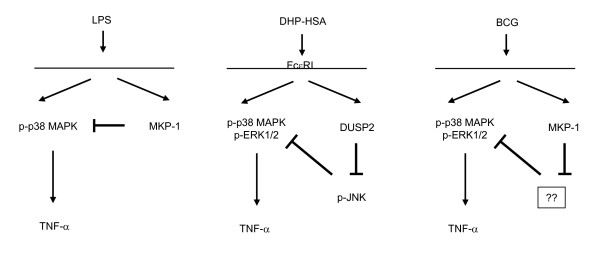
MKP-1 plays a critical role in the regulation of cytokine expression upon mycobacterial infection. LPS model was provided according to literature findings (Left). In this scenario, LPS activates MKP-1, which in turn dephosphorylates and deactivates phospho-p38 MAPK, resulting in less TNF-α induction. However, the situation in DHP-HSA activation of DUSP2 is more complicated (Middle), since the phosphatase activity causes subsequent inhibition of phospho-JNK which leads to the de-repression of phospho-p38 MAPK. Consequently, the combined effects of this cascade results in more TNF-α expression. The unexpected antimycobacterial role of MKP-1 (Right) may be explained by events similar to the DUSP2 effects. In this case (Right), there was an inhibition of unknown pathways or kinases downstream of MKP-1, and the unknown factor in turn inhibits MAPKs activation leading to more TNF-α induction. The details and kinase targets are yet to be identified.